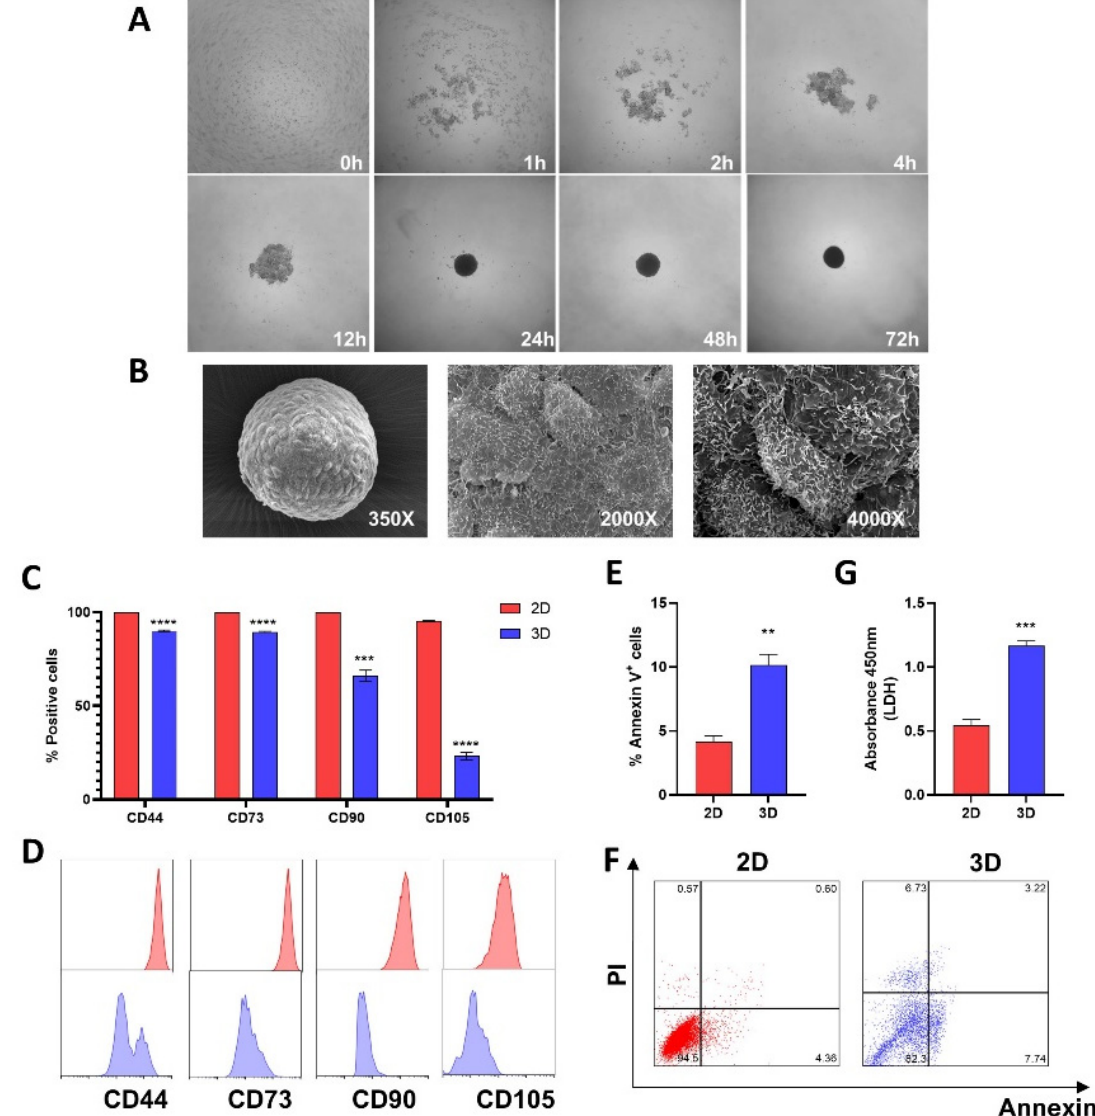
Figure 1. Spheroid formation and MSCs characterization. ( A ) Chronological record of 3D ‐ MSCs compaction. Images were captured at 0, 1, 2, 4, 12, 24, 48, and 72 h after 3D ‐ MSCs seeding on 96 ‐ well agarose ‐ coated plates at 4 × magnification. ( B ) Scanning electron microscopy images. From left to right the magnifications are 350, 2000, and 4000 ×. ( C ) CD44, CD73, CD90, and CD105 expression on 2D ‐ MSCs (2D) and 3D ‐ MSCs (3D). ( D ) Representative histograms of one MSC sample evaluated. Red color corresponds with 2D ‐ MSCs, while blue color corresponds with 3D ‐ MSCs. ( E ) Percentages of apoptotic (annexin V+) 2D and 3D ‐ MSCs evaluated after their dissociation with collagenase IA. ( F ) Representative flow cytometric dot plots showing expressions of PI and Annexin V in 2D and 3D ‐ MSCs. ( G ) LDH release by 2D and 3D ‐ MSCs. ** p < 0.01; *** p < 0.001; **** p < 0.0001.